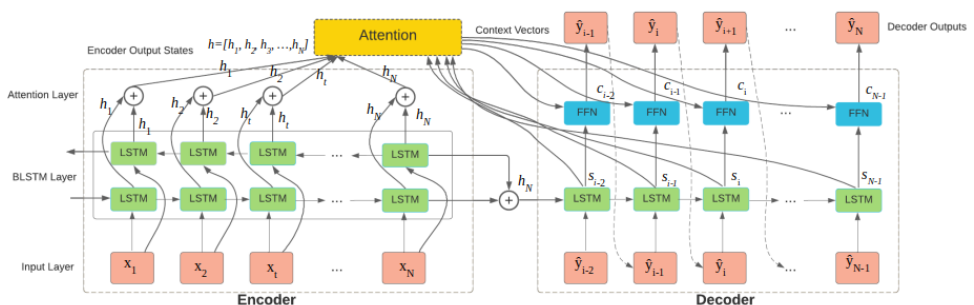
Figure 2. Structure of the proposed Seq2Seq model, where the attention layer is ignored for